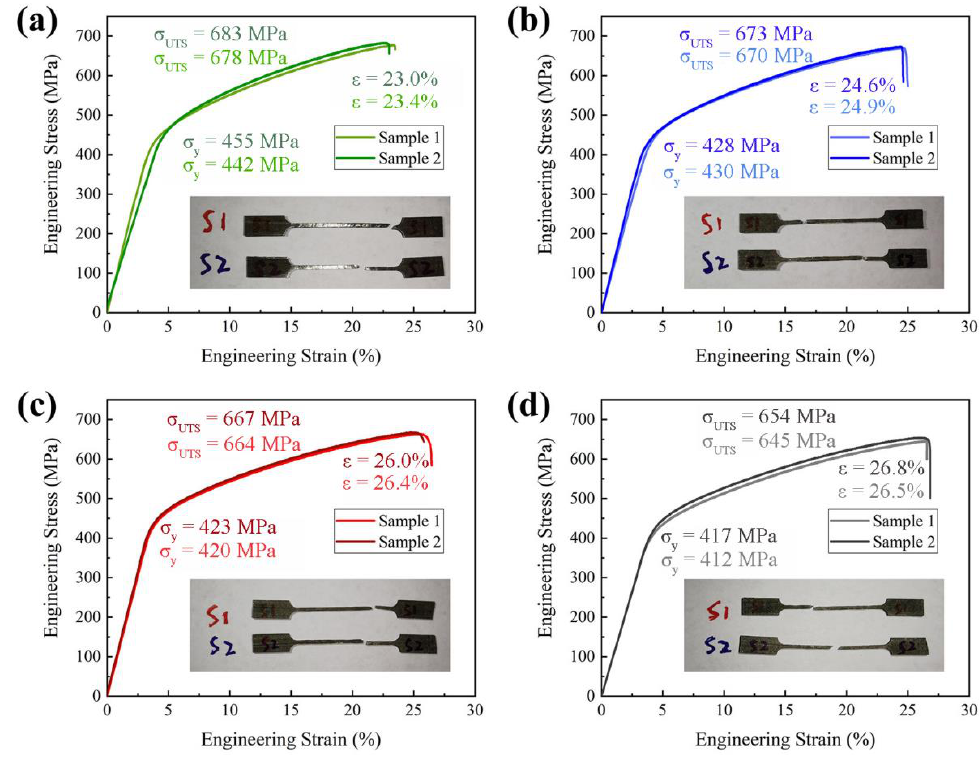
Figure 12. The tensile stress-strain curves of the LMD-Al 0.5 FeCoCrNi walls under different heat dissipation rates: ( a ) T-0; ( b ) T-20; ( c ) T-40; ( d ) T-60.